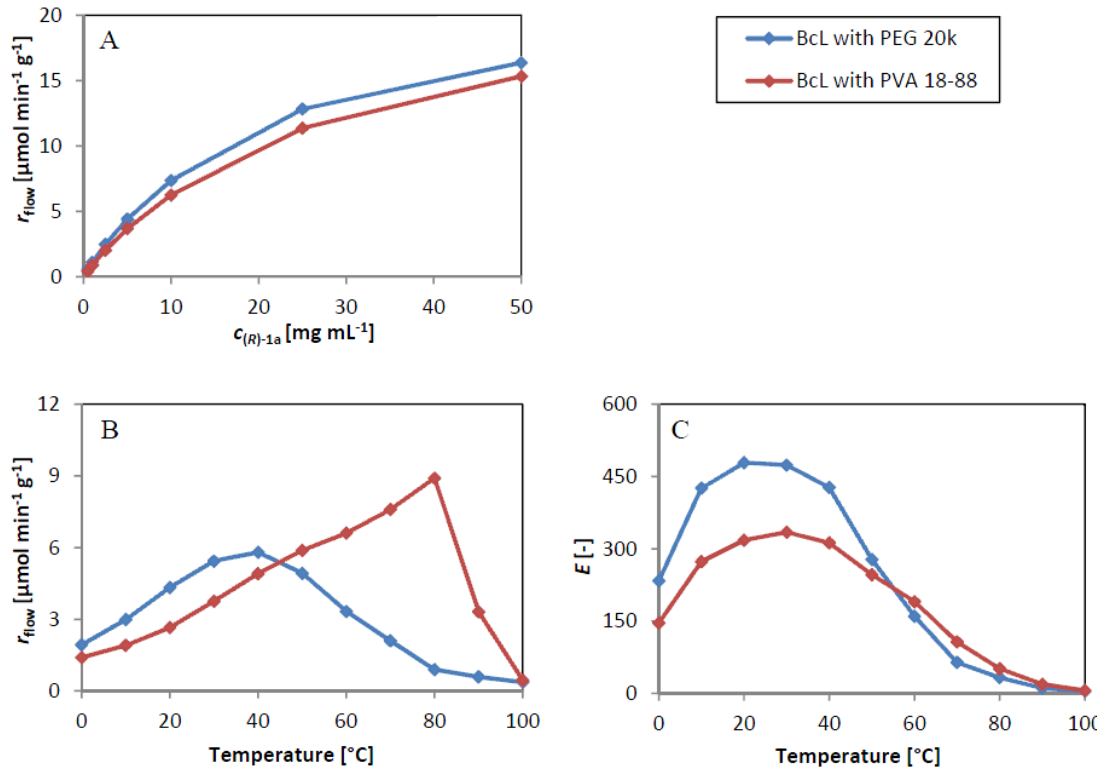
Figure 4. Kinetic resolutions of racemic 1-phenylethanol ( rac -1a ) in continuous-flow packed-bed bioreactor. Effect of the substrate concentration on specific reaction rate, r temperature on specific reaction rate, r ( B ) and temperature on enantiomeric ratio, E ( C flow